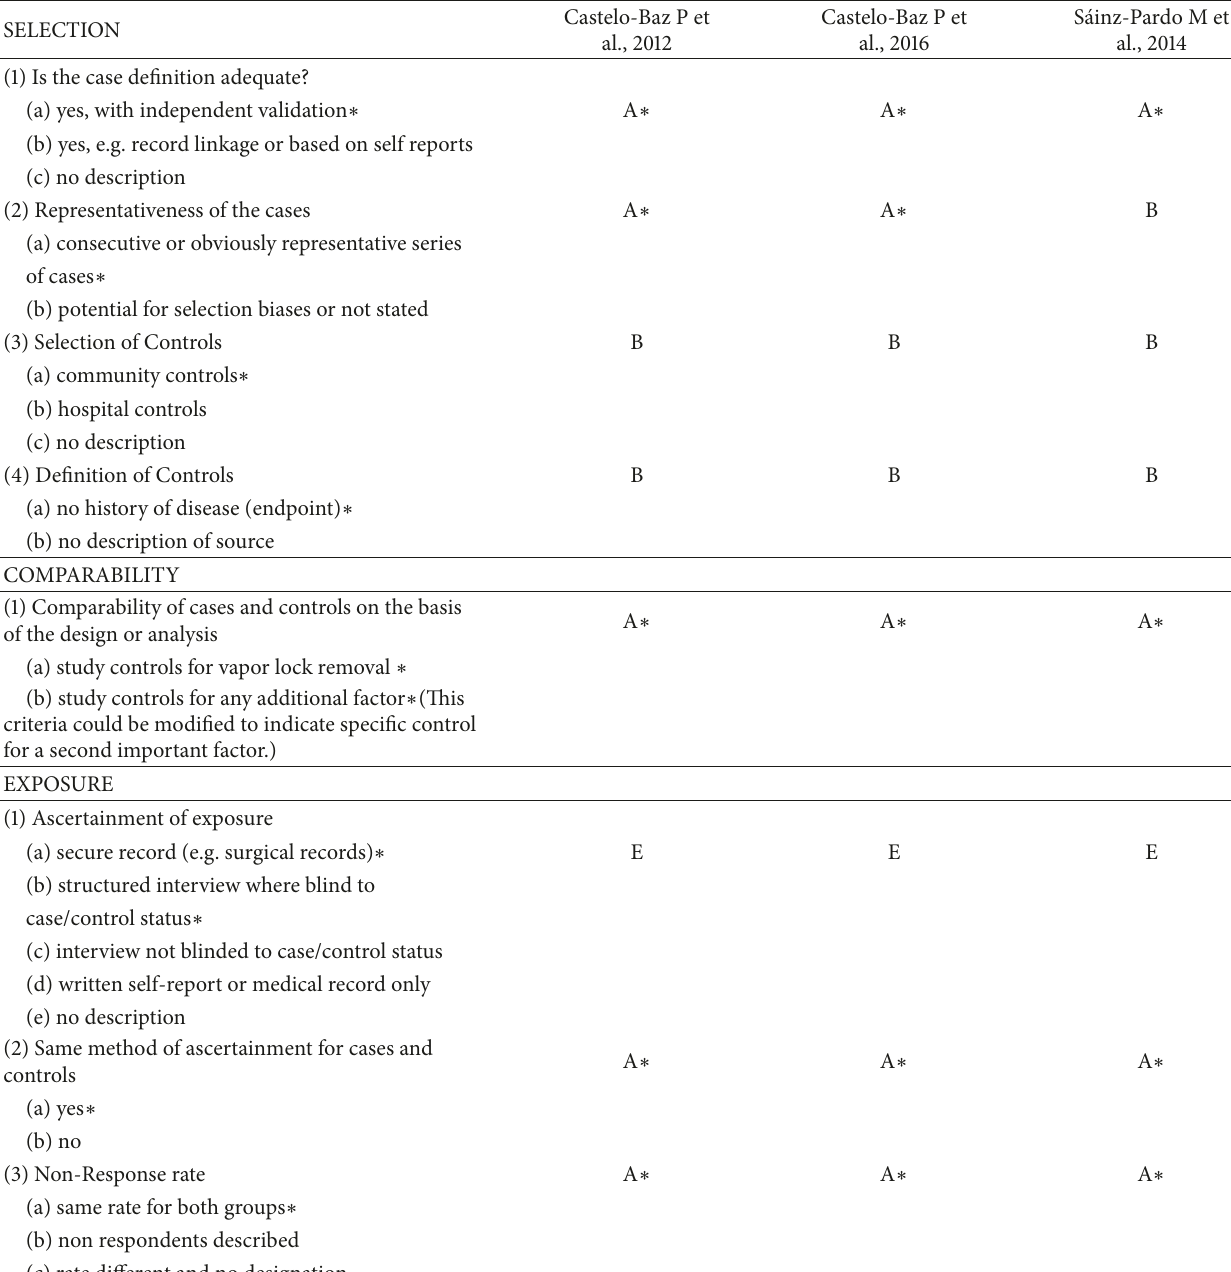
Table 2: Application of the Newcastle-Ottawa scale for case-control studies in order to evaluate the Risk of Bias between the three studies selected for the present systematic